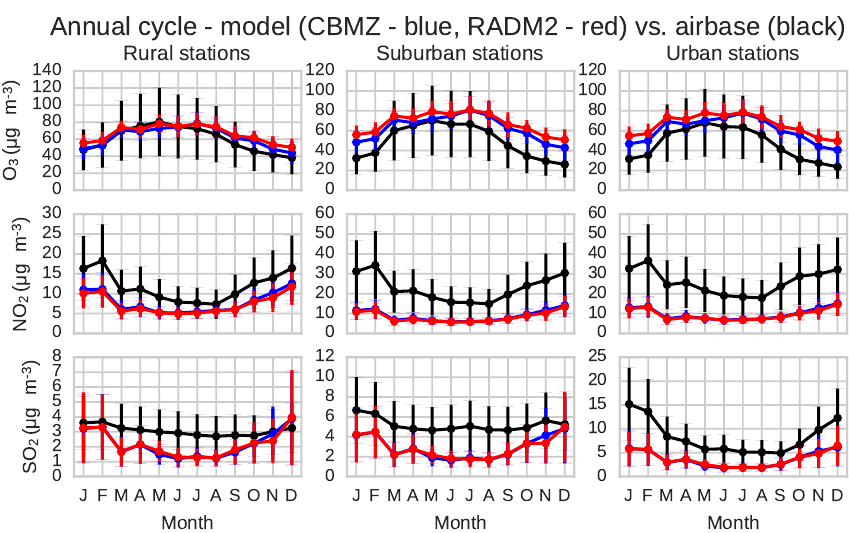
Figure 4. Comparison of monthly gas concentrations between model values (CBMZ – blue, RADM2 – red) and measurements (black). Error bars indicate averaged standard deviation.